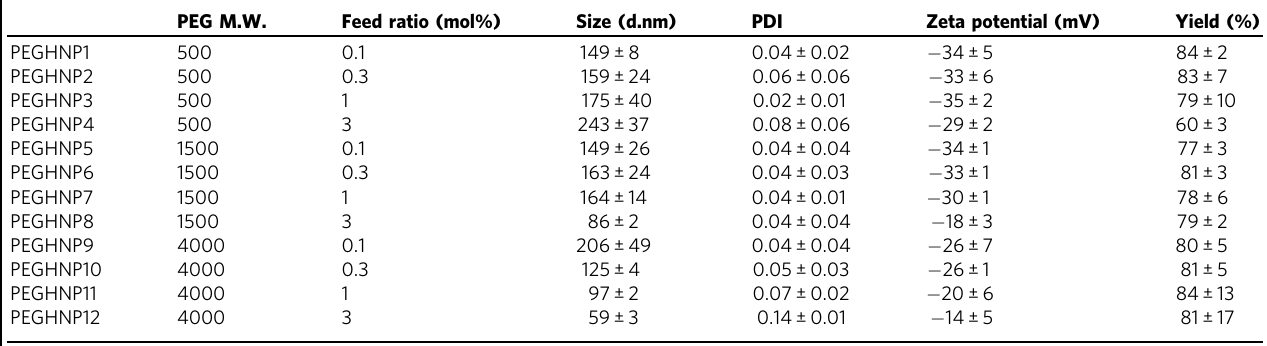
Table 3 PEG M.W., size, zeta-potential, and PDI of PEGHNPs. PEG